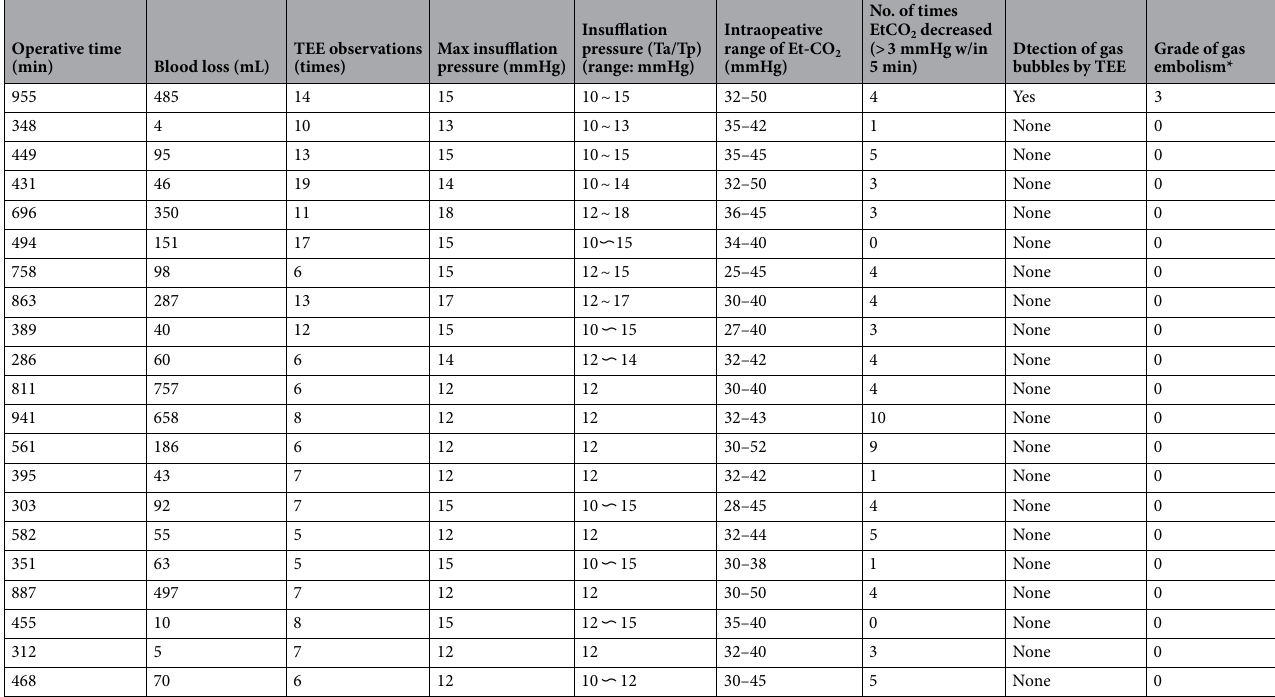
Table 3. Operative parameters. *Tübingen Venous Air Embolism Grading Scale (Table